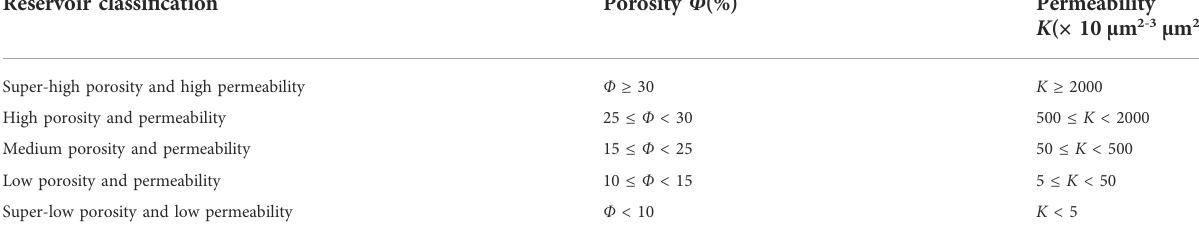
TABLE 1 Classi fi cation standard for physical characteristics of clastic rock reservoirs (by national reserves committee, 1997). Reservoir classi fi